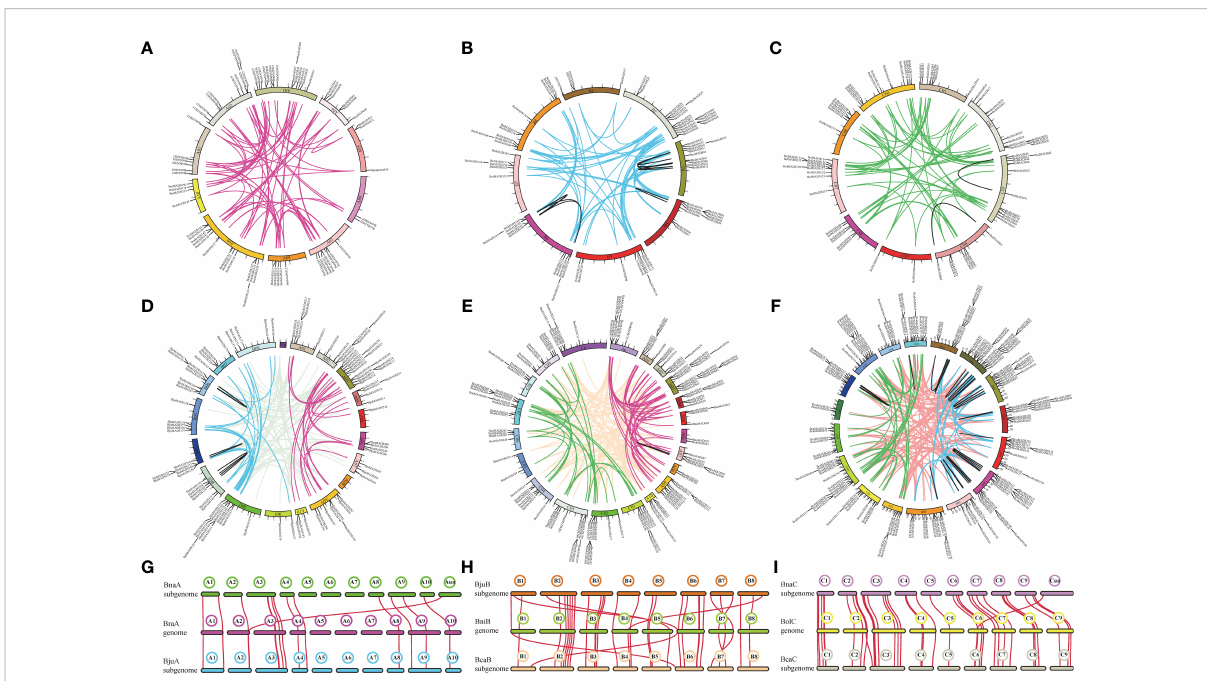
FIGURE 4 Duplication events and synteny of MIKC-type MADS-box genes. (A-F) Chromosome location information and segmental duplication of MIKC- type MADS-box genes. (A – F) indicate the segmental duplication events occurring within the genomes of B. rapa , B. nigra , B. oleracea , B. juncea , B. napus , and B. carinata , respectively. Colored lines represent replication events identi fi ed within different subgenomes, and black lines represent duplication gene pairs that occur on the same chromosome. (G-I) Genomic synteny between progenitor Brassica species B. rapa , B. nigra , and B. oleracea ) and the allotetraploid species ( B. carinata , B. juncea , and B. napus